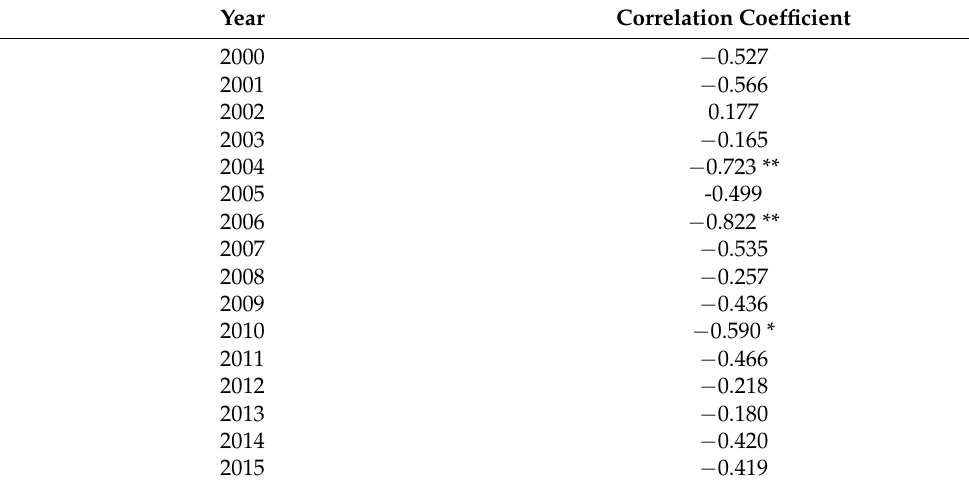
Table 4. Correlation analysis between SM and air wind speed.